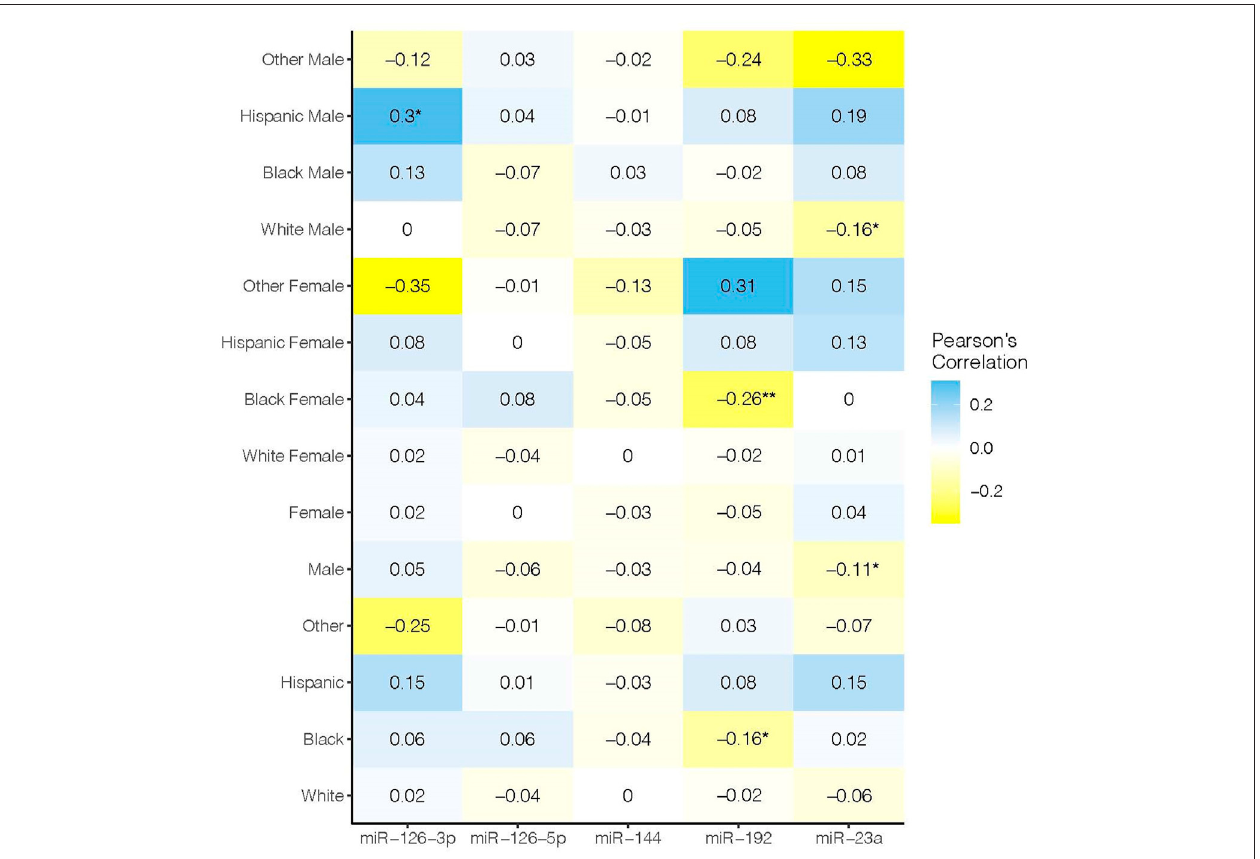
FIGURE 1 | Rows show race/ethnic group. Columns show microRNAs assessed. Color intensity shows the magnitude of the correlation. Statistically signi fi cant values are denoted with an asterisk.